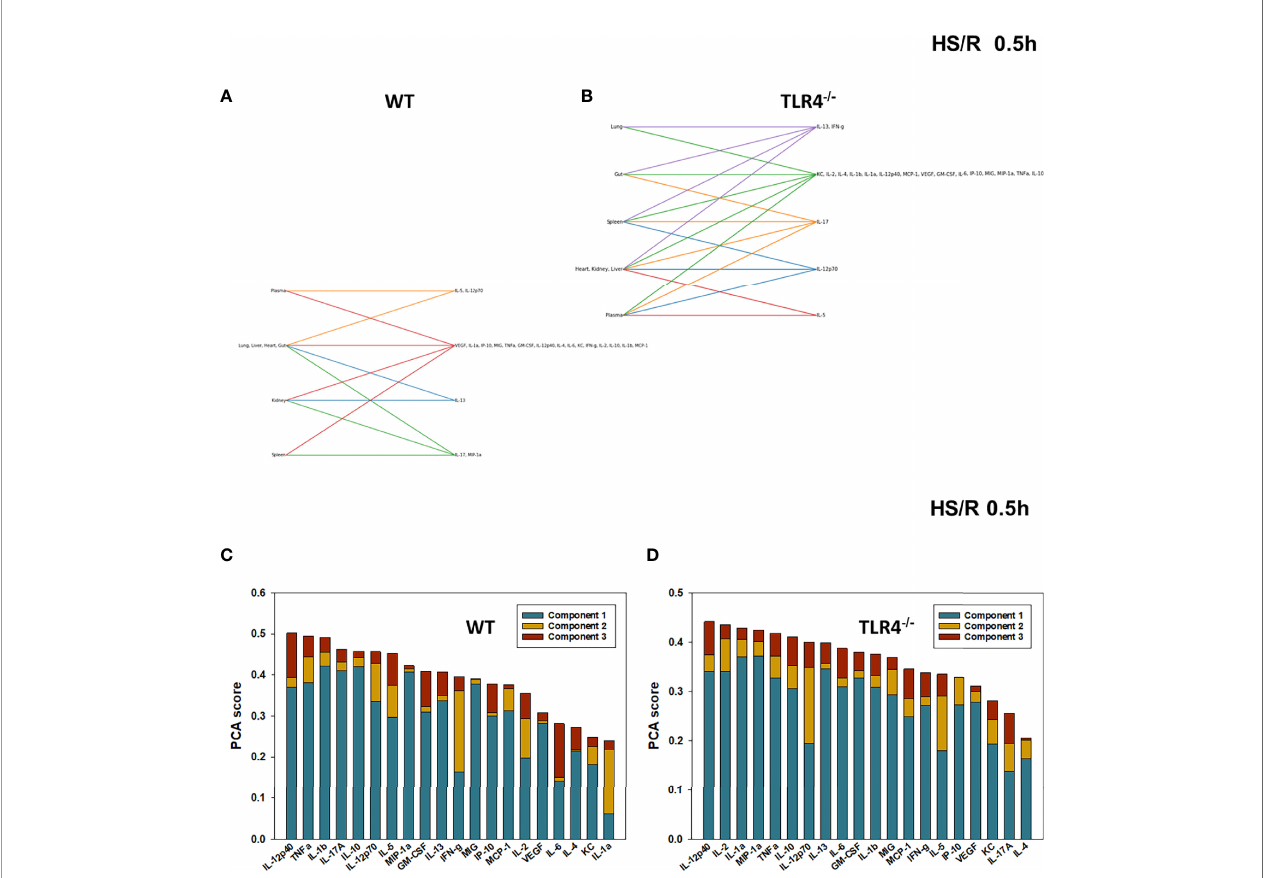
FIGURE 4 | Hypergraphs and Principal Component Analysis of in fl ammatory mediators from WT and TLR4 -/- mice subjected to HS/R (0.5h). Plasma and tissue samples from heart, lung, liver, gut, spleen, and kidney were collected from WT and TLR4 -/- mice subjected to HS/R (0.5h) and analyzed using Luminex ™ as described in Materials and Methods . Panels (A, B) show the hypergraphs and Panels (C, D) show the PCA results (70% variance) in WT and TLR4 -/- mice,